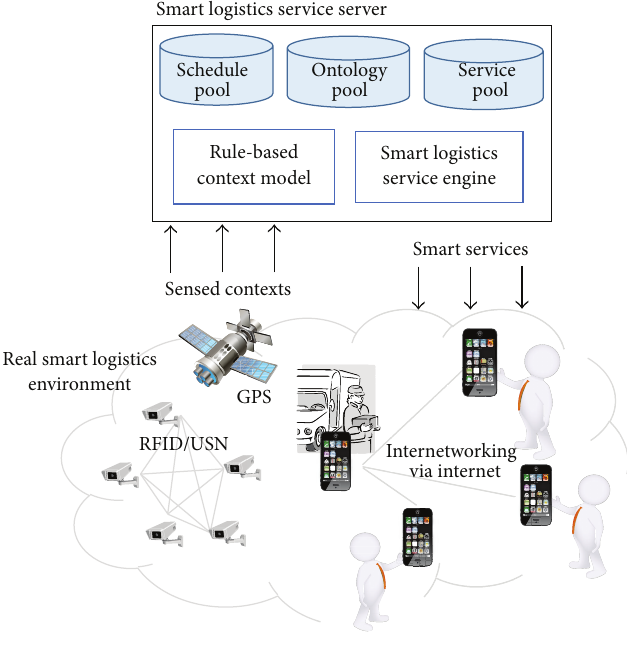
Figure 3: Service model of logistics service.